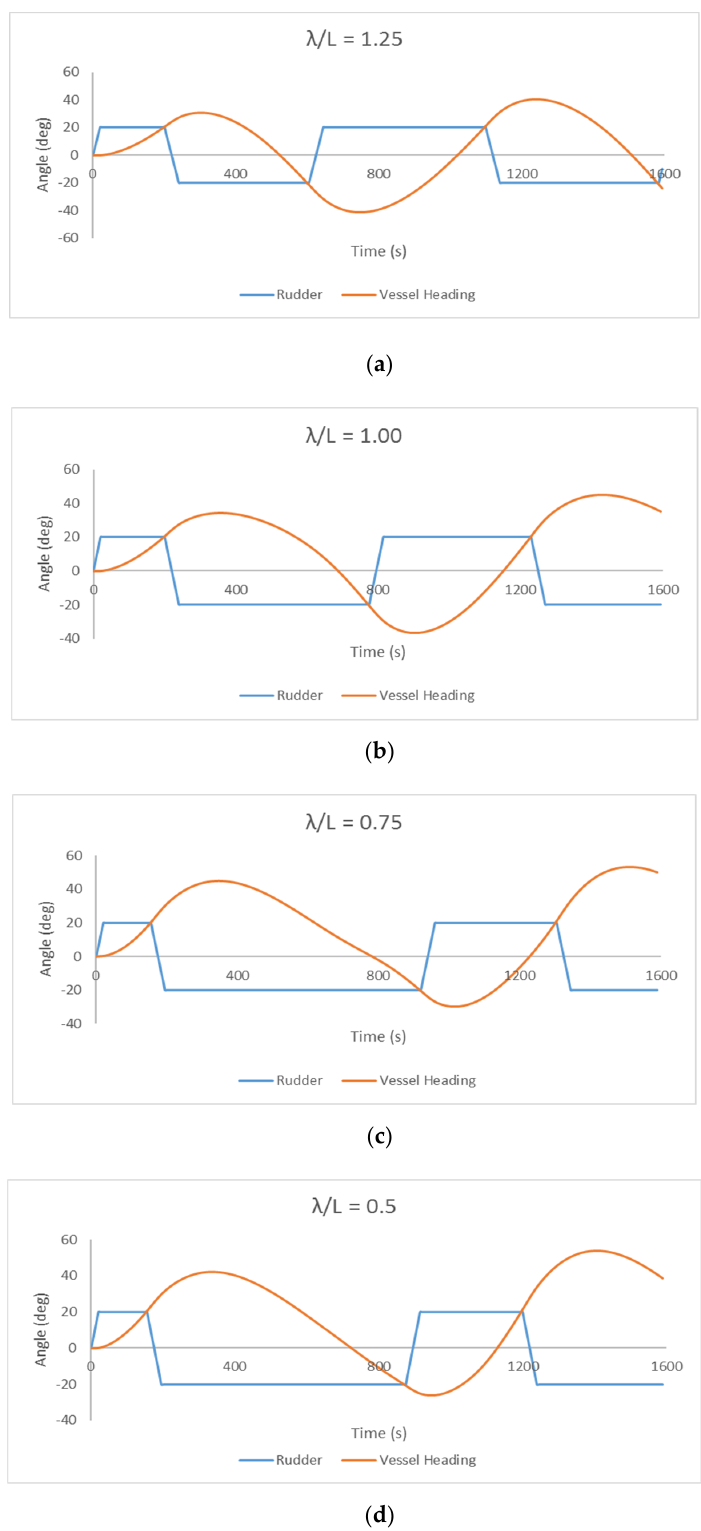
Figure 8. KVLCC’s 20/20 (starboard-side) Zig-Zag tests in regular waves with 90 deg at t = 0 and four different ratios between wave length and vessel length λ : ( a ) λ = 1.25; ( b ) λ = 1; ( c ) λ = 0.75; ( d ) λ = 0.5. As shown in Figures 9–13, the numerically simulated turning trajectories for the KCS vessel have been presented and compared with the model test results in both calm water and regular waves.